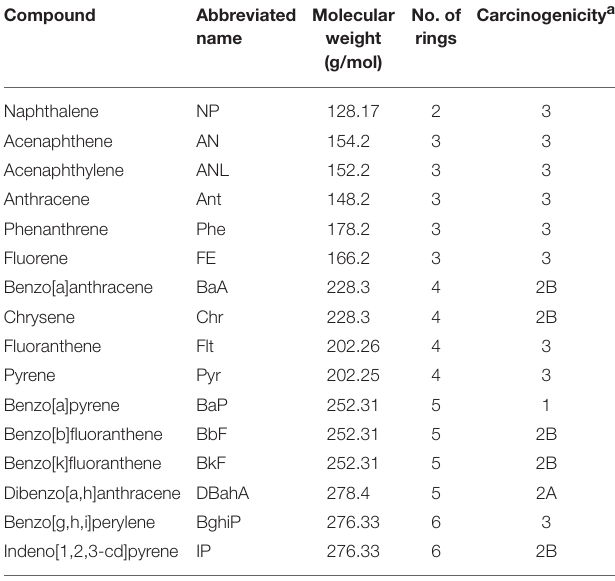
TABLE 2 | Selected physical–chemical properties and carcinogenicity classification of the 16 PAHs classified by the US EPA as priority pollutants.